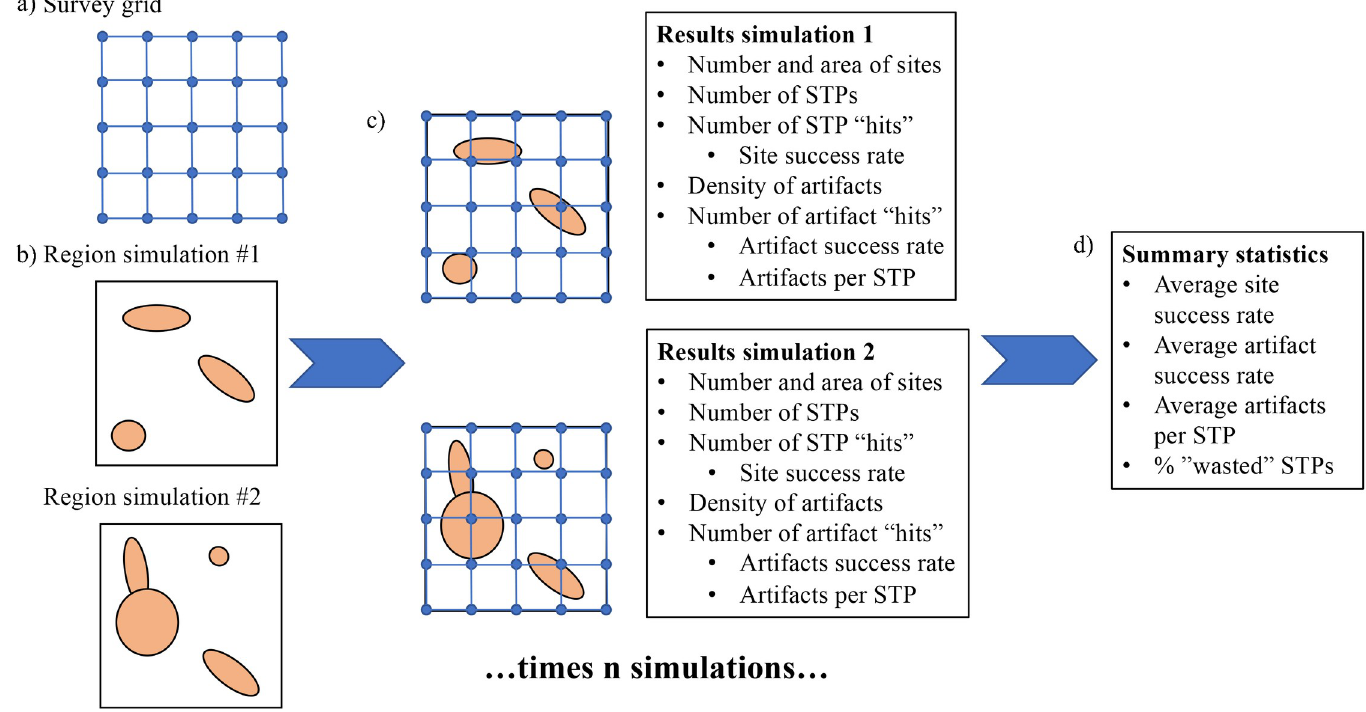
Fig 2. Schematic of DIGSS